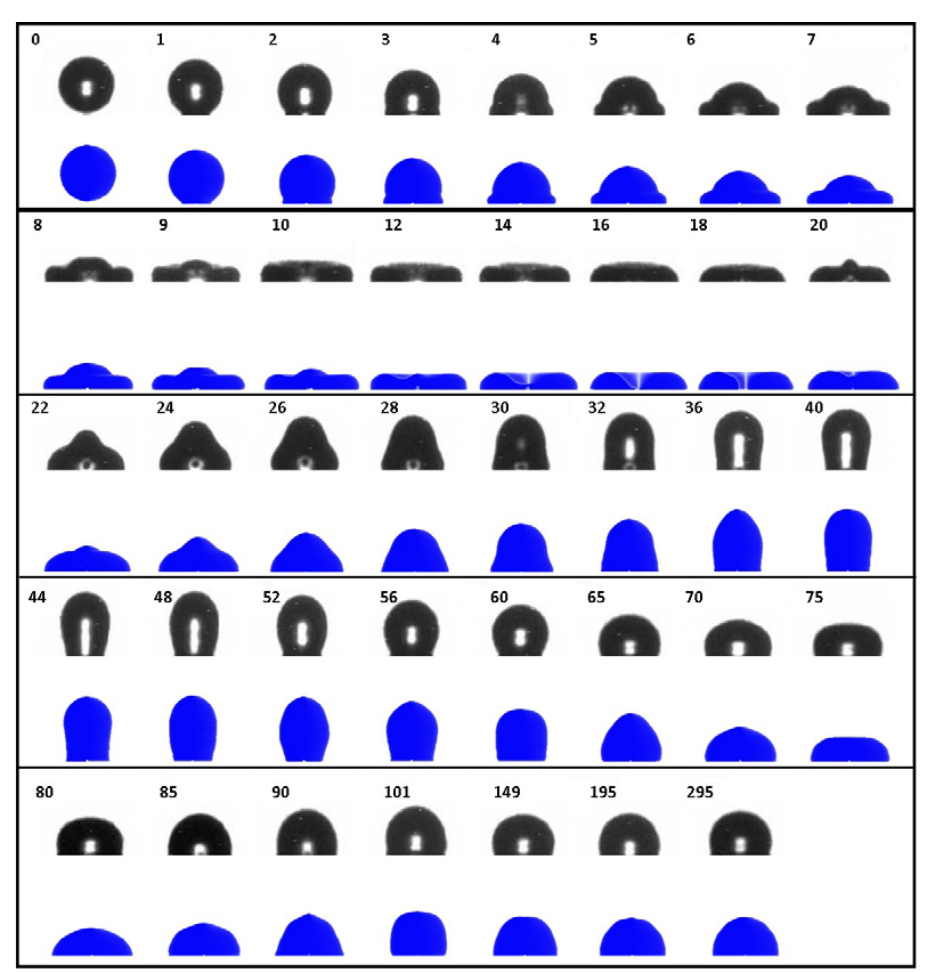
Figure 4. Temporal evolution of droplet shape during impingement at various discrete times up to 295 µs: experimentally measured (black) [15]; numerical simulation (blue).